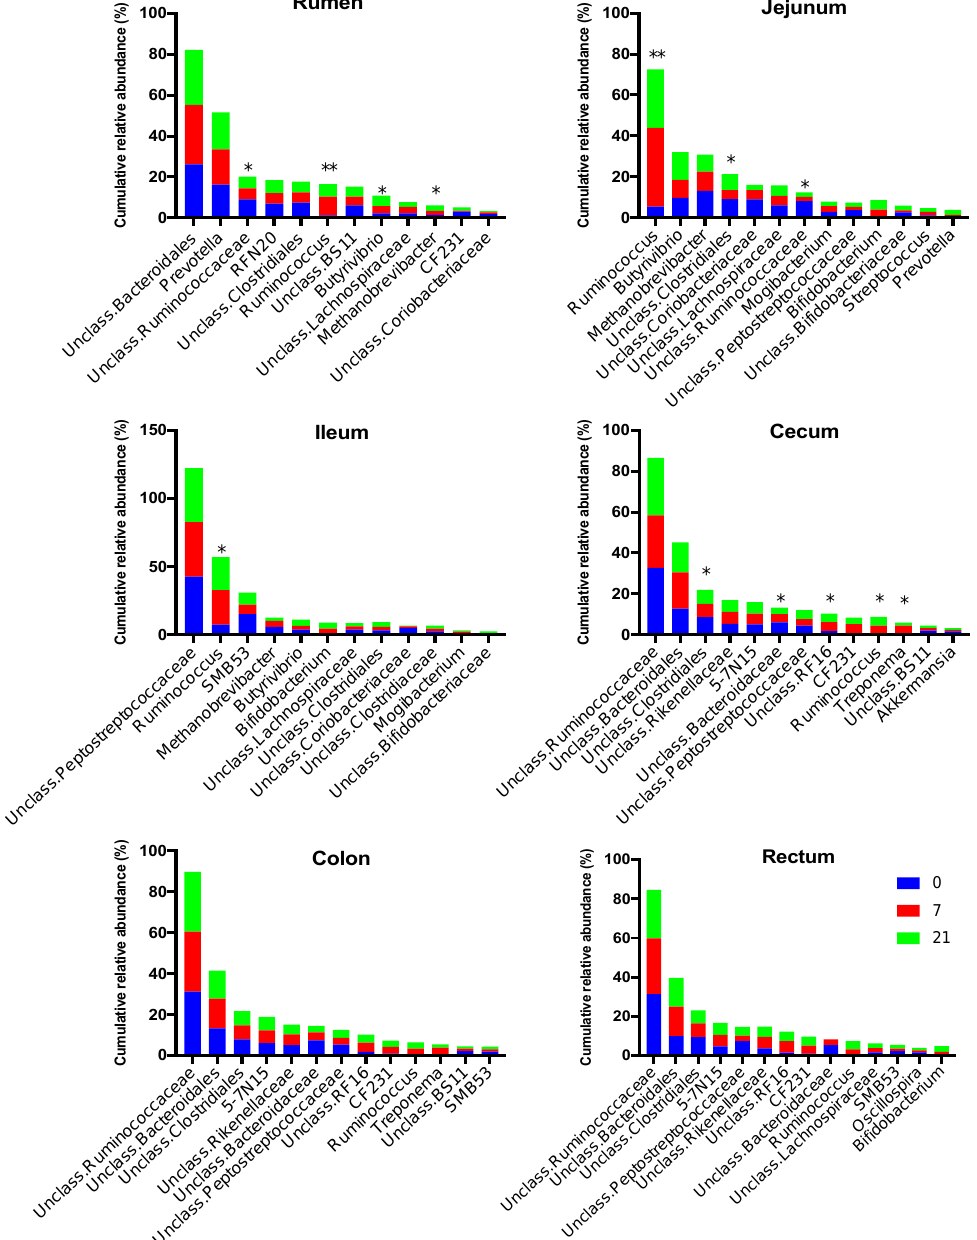
Figure 7. Effect of treatment (0 = no grain feeding, 7 moderate grain feeding for 7 d, 21 = moderate grain feeding for 21 days) on the most abundant genera region of the digestive tract. * = relative abundances of genera differ significantly ( p < 0.05) among treatments, ** = = relative abundances of genera differ significantly ( p < 0.01) among treatments